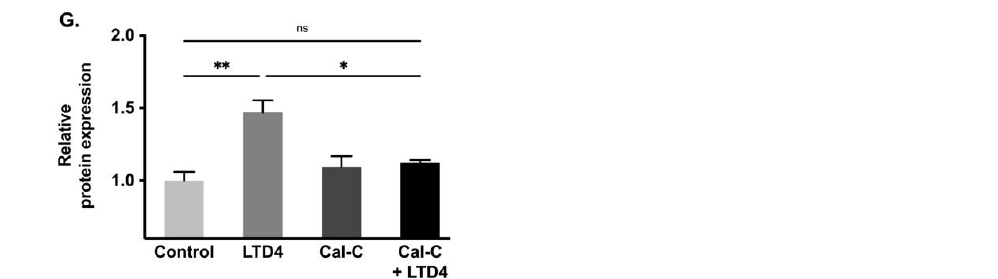
Figure 7. Quantification of Na-K-ATPase α 1 and Na-K-ATPase β 1 through Western blots when treated with LTD4 and calphostin-C (PKC inhibitor) for 24 h. ( A ) Representative Western blots of Na-K-ATPase α 1, Na-K-ATPase β 1, PKC- α and GAPDH (loading control) in whole cell lysate (WCL). ( B ) Representative Western blots of Na-K-ATPase α 1, Na-K-ATPase β 1, and Ezrin (loading control) in plasma membrane (PM). Densitometric quantitation of blots, ( C ) Na-K-ATPase- α 1, ( D ) Na-K-ATPase- β 1, ( E ) PKC α in WCL and ( F ) Na-K-ATPase- α 1, ( G ) Na-K-ATPase- β 1 in PM. Values are relative to control and normalized to GAPDH or Ezrin. Values are represented ± SEM, ( n = 4, Tukey’s multiple comparisons test). * p < 0.05, ** p < 0.01; *** p < 0.001, ns., not significant.